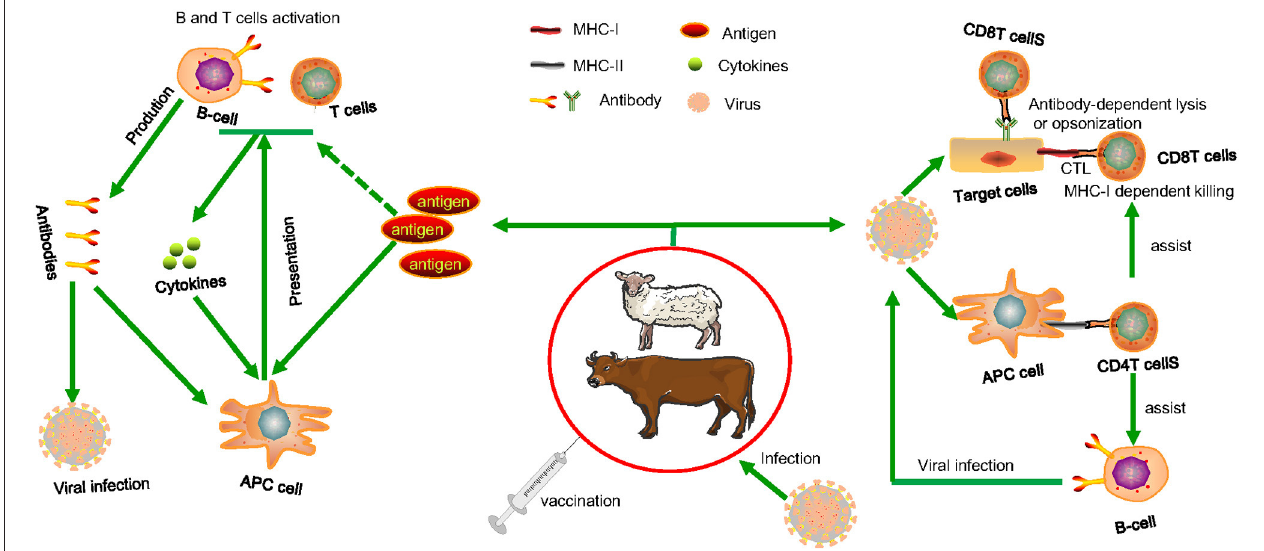
FIGURE 1 | The cellular cooperation in the immune response. Following vaccination, advanced phagocytes present the processed antigens to naive B or T cells, which can be activated if co-stimulatory signals are produced (derived from the interaction of PAMPs with cellular PRRs). When lymphocytes become stimulated, they release soluble mediators and antibodies that cause inflammatory responses. In this simplified illustration, immune systems that may protect animals from invading viral infections are illustrated. CTL that identifies pathogen-derived epitopes presented in combination with MHC class I on infected cells or antibody-dependent lysis or opsonization of infected cells expressing pathogen molecules. Extracellular and intracellular pathogens on their way to infect other cells, can be attacked by specific circulating antibodies and killed by lysis or agglutination or phagocytosed by macrophages and neutrophils. Assistance is required from pathogen specific CD4 helper T cells both for antibody and CTL induction and that are activated after interaction with pathogen-derived epitopes presented in combination with MHC class II molecules on the surface of MHC class II + antigen-presenting cells. When pathogens infect antigen-presenting cells, they can be killed directly by CD4T cells and CD8 CTL through the induction of mediators such as interferon gamma (IFN- γ ), reactive oxygen and nitrogen species, and indoleamine 2,3-dioxygenase. Pathogen toxins can be neutralized by circulating antibodies, resulting in decreased infection-related clinical